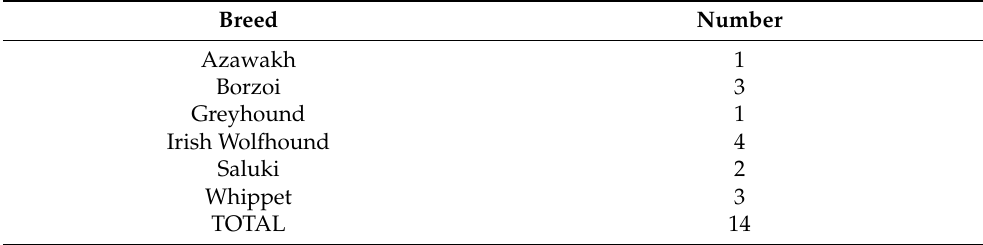
Table 2. Distribution of canine breed in the dolichomorphs group.